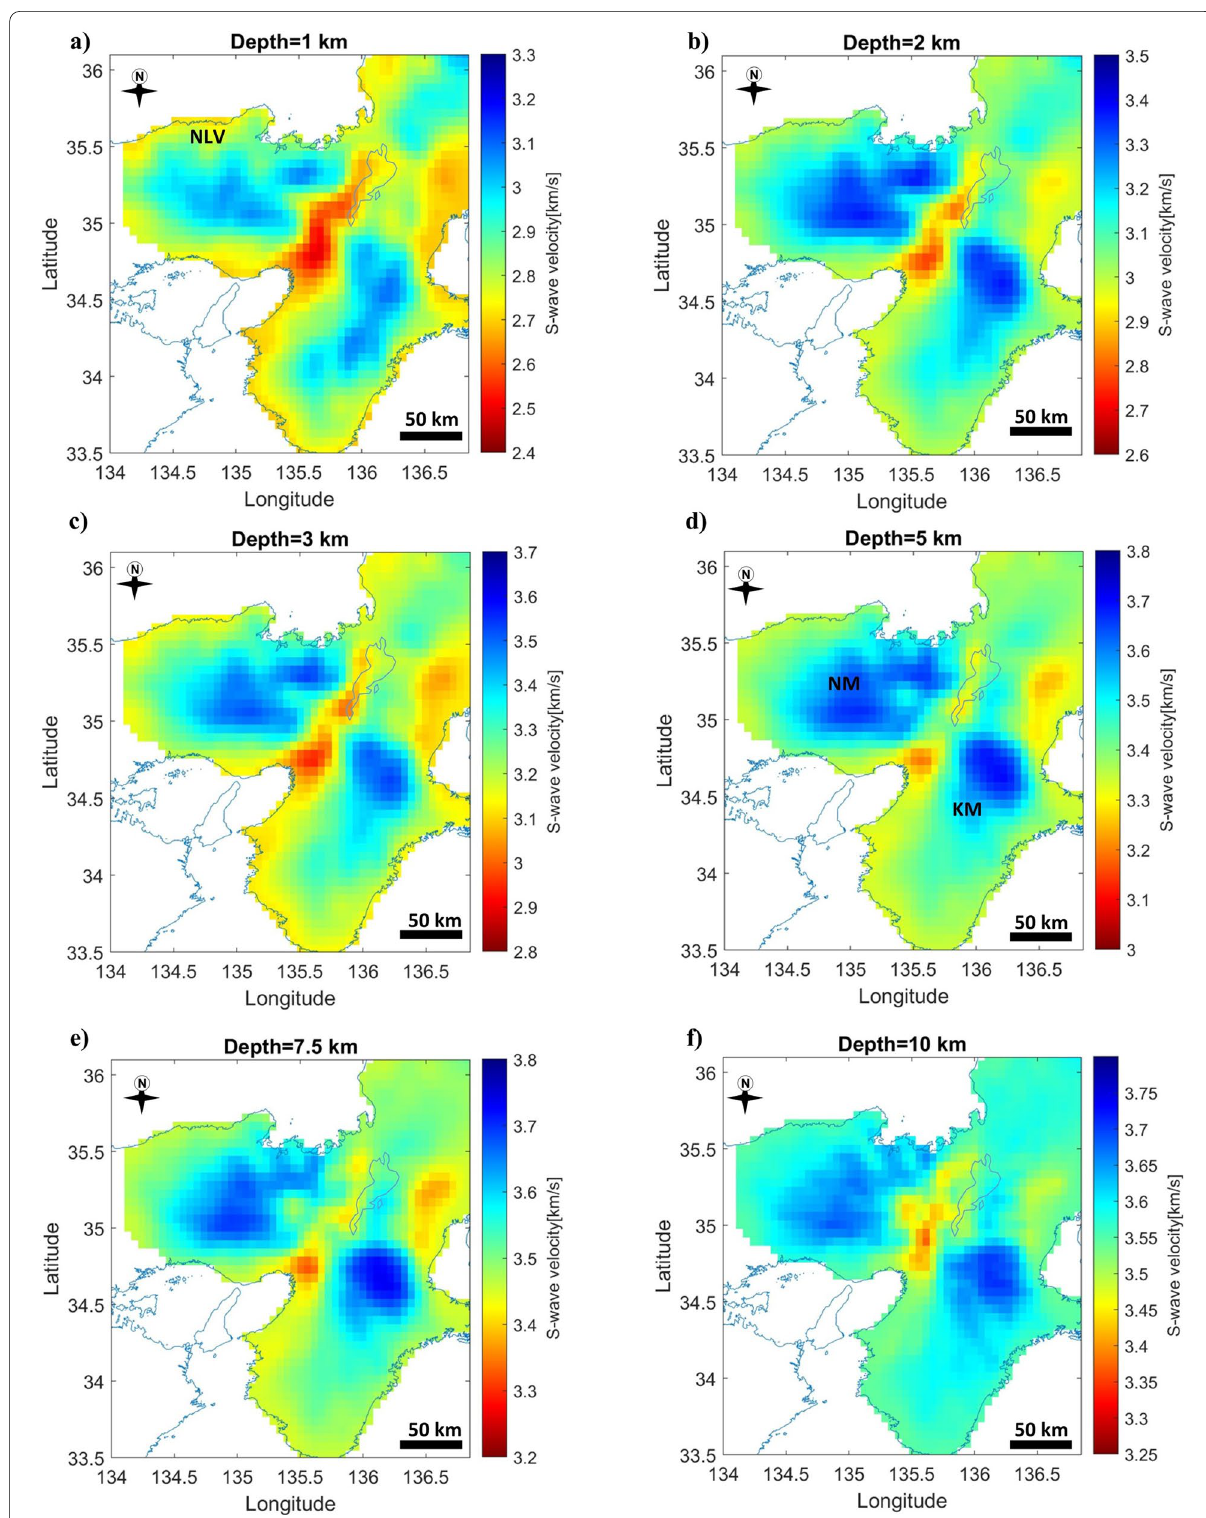
Fig. 7 Horizontal slices of the S-wave velocity model at discrete depth levels below sea level. Depth is shown above each respective panel. a – f S-wave velocity models without showing the active faults (S-wave velocity models before correcting for the effects of topography are shown in Figure S4). NM and KM represent the prominent high-velocity